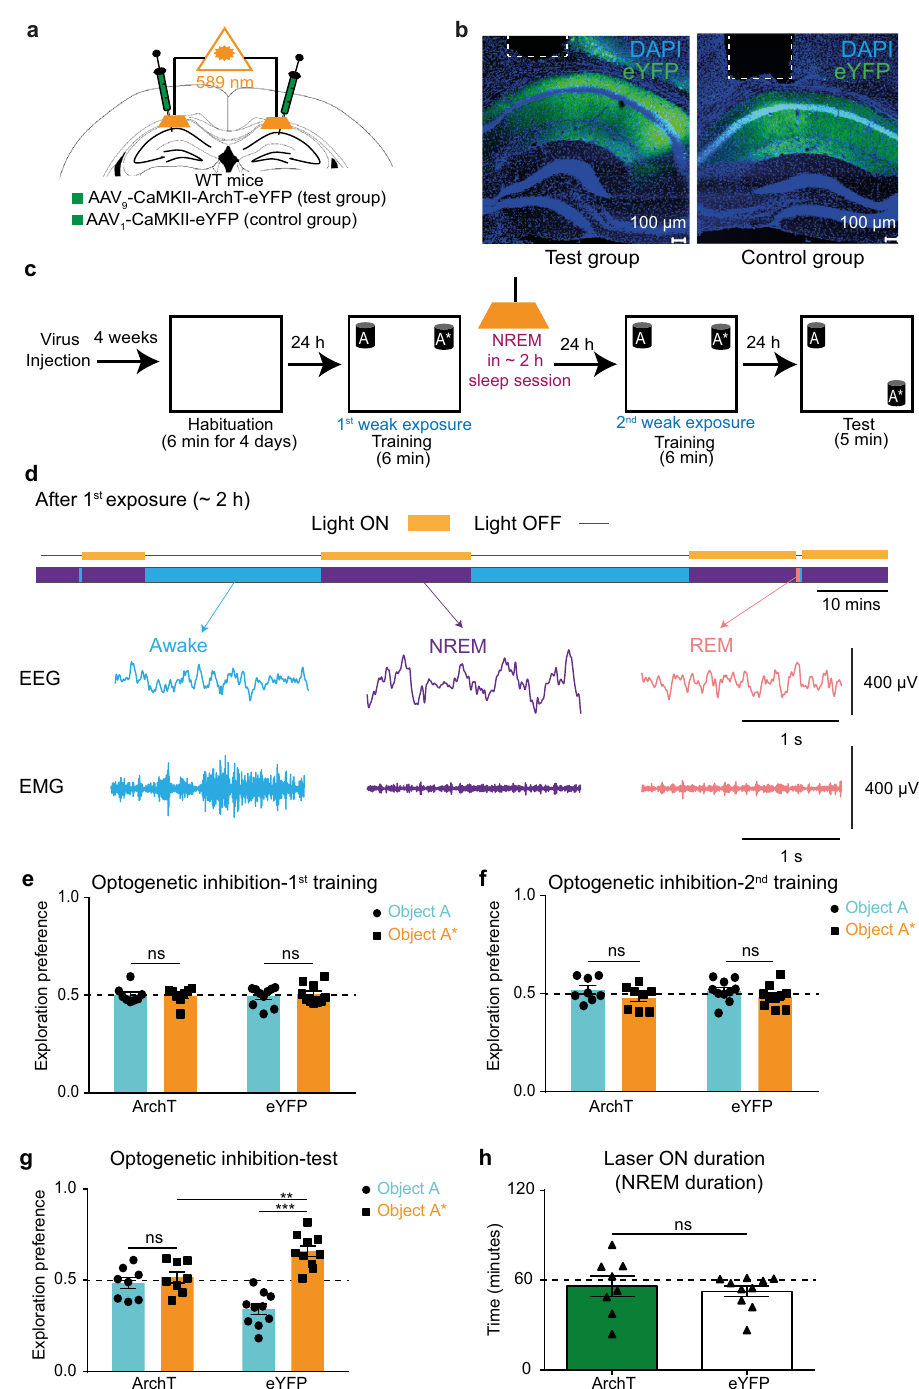
Fig. 6 Causal link between of fl ine activity during post-learning NREM sleep and long-term storage of STM trace. a Diagram of AAV injection and CA1 optic fi ber placement. b Representative CA1 sections showing ArchT-eYFP (Left: test group) and eYFP (Right: control group) protein expressions (scale bar = 100 μ m; dashed line: guide cannula location). c Experimental design for optogenetic silencing of STM trace storage using NOL two-training paradigm during post-learning NREM sleep. d Example from one mouse showing 2-hour EEG/EMG recordings with laser ON during NREM state only (top), and example of EEG/EMG traces for NREM, REM, and awake states (bottom) (see Methods section for details). Exploration preference for each object during the fi rst ( e ) and the second ( f ) training sessions for ArchT ( n = 8) and eYFP ( n = 10) groups. g Exploration preference for each object during the test session in ArchT ( n = 8) and eYFP ( n = 10) groups. h Duration of NREM sleep (laser ON) in ArchT ( n = 8) and eYFP ( n = 10) groups. Comparisons were made using wilcoxon signed rank sum test ( e ) and paired student ’ s t-test for comparing object A and object A* in the same group, and unpaired Student ’ s t-test for comparing object A* within different groups ( f , g ) and wilcoxon rank sum test ( h ); ns not signi fi cant ( P > 0.05), ** P < 0.01, *** P < 0.001. Data are presented as the mean ±